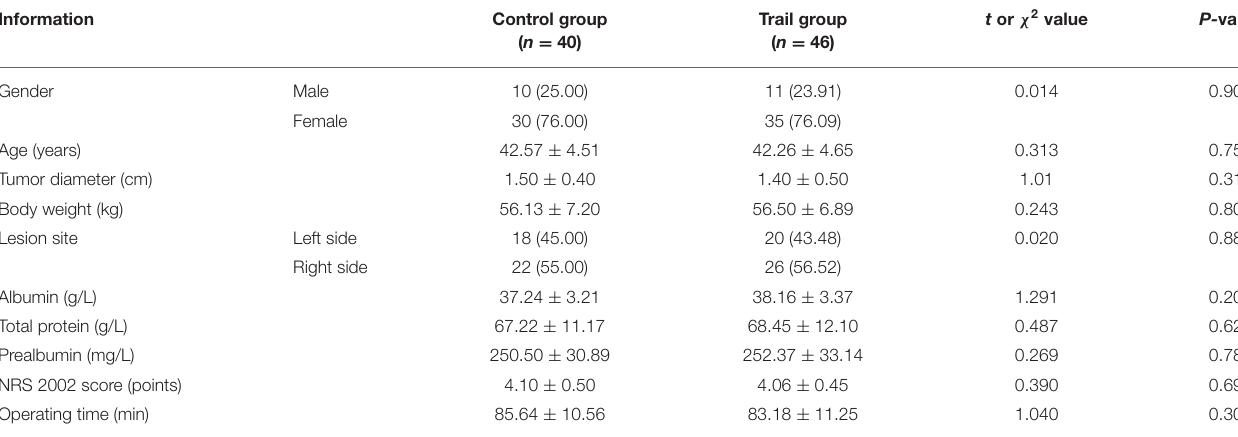
TABLE 1 | Comparison of the base of 2 groups (Mean, SD; %).